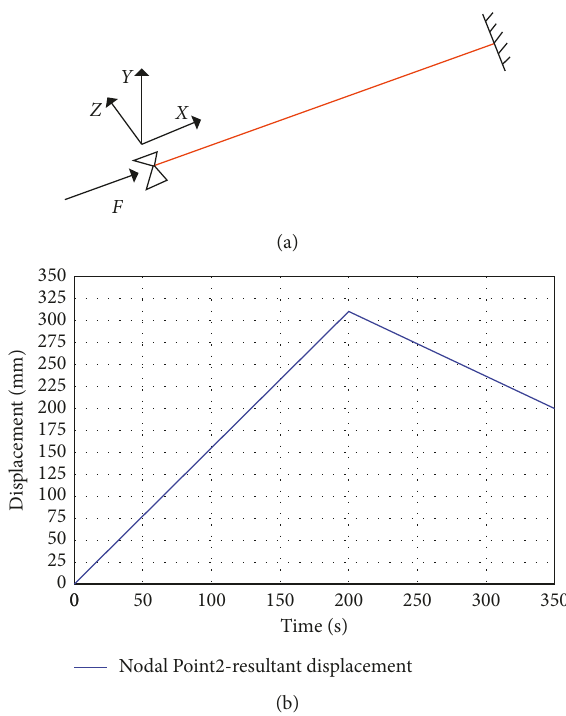
Figure 20: (a) shock absorber model; (b) imposed displacement curve.